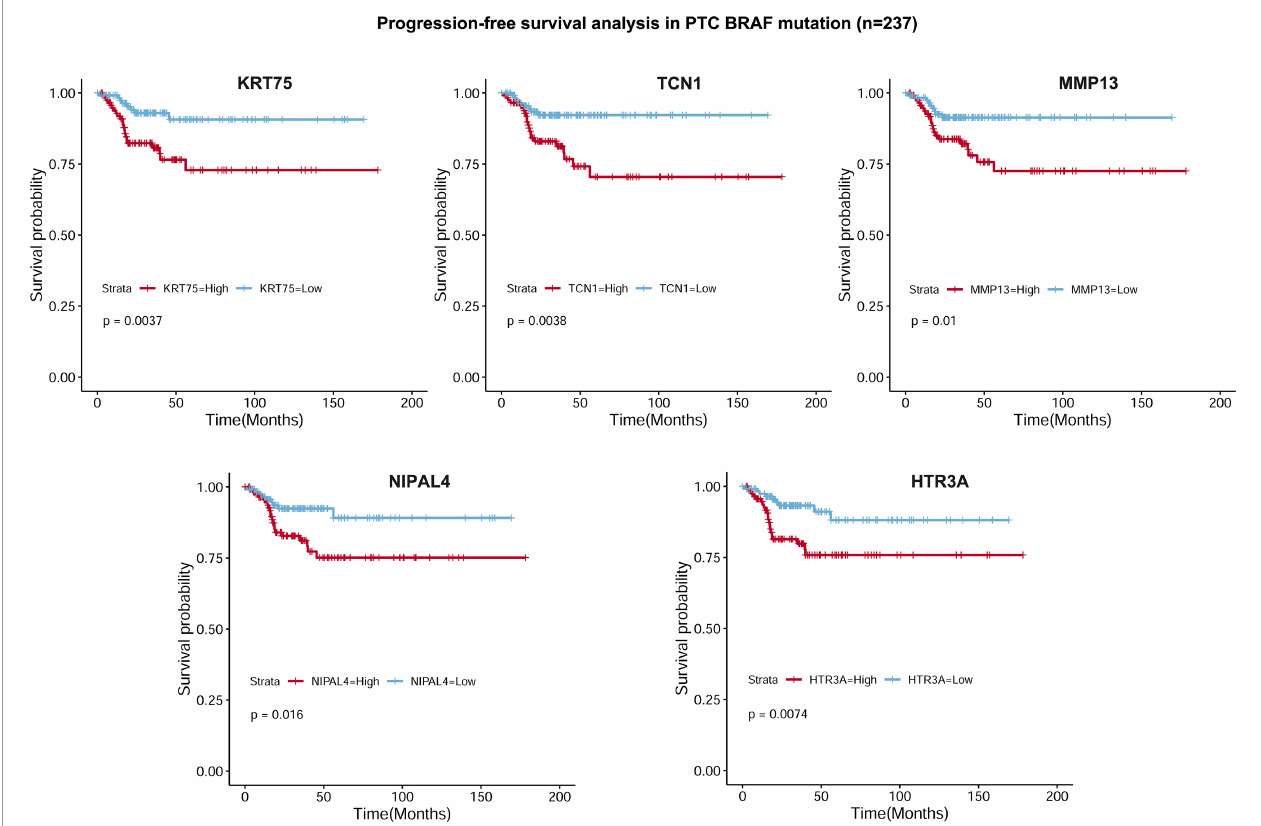
FIGURE 6 | Kaplan – Meier survival curves based on 5 DEGs. Progression-free survival analysis revealed that higher expression levels of KRT75, TCN1, MMP13, NIPAL4 and HTR3A were related to shorter PFS in PTC patients with BRAF mutation ( p <